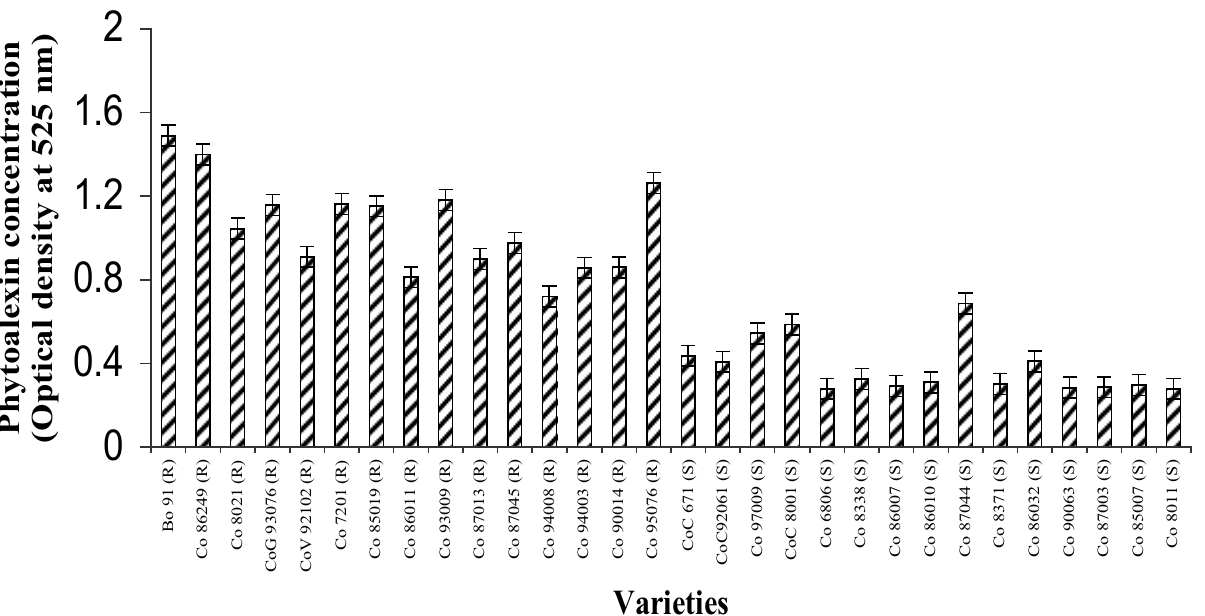
Fig 1. Phytoalexin (3-deoxyanthocyanidins) accumulation in the nodal tissues of sugarcane varieties in response to Colletotrichum falcatum toxin application. R, resistant variety; S, susceptible